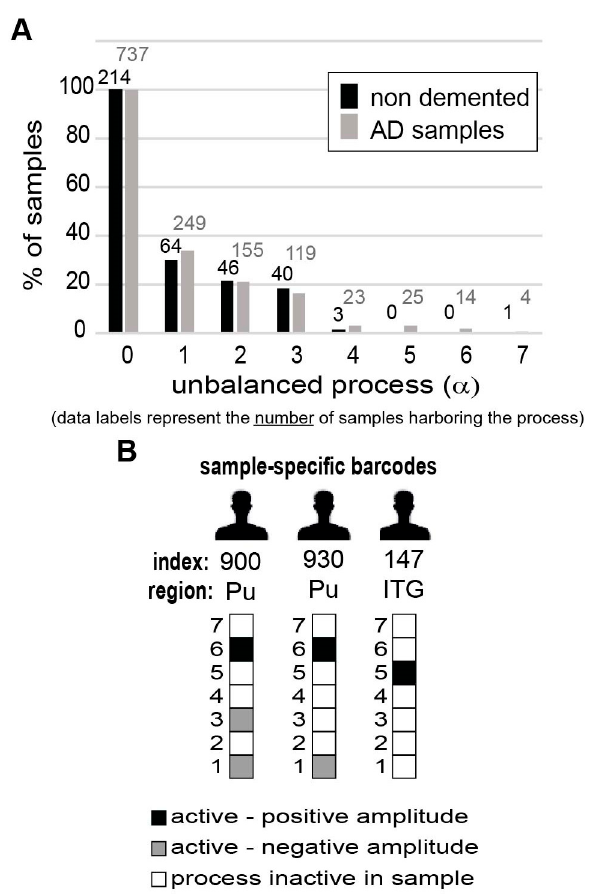
Figure 5. The altered transcriptional signature of every individual sample can be represented by a sample-specific barcode. ( A ) Frequency of expression of the different unbalanced processes in non-demented vs. AD samples. The graph shows that the seven unbalanced processes identified by surprisal analysis (SA) are each active in a similar percentage of non-demented vs. AD-bearing samples, and none can distinguish between the types of samples. ( B ) Sample-specific barcodes enable characterization of the complete altered transcriptional signature in every sample. The barcodes that characterize the three samples from Figure 4 are exemplified here. The sample-specific barcodes denote which unbalanced processes are active in the sample, including the sign of the amplitude.